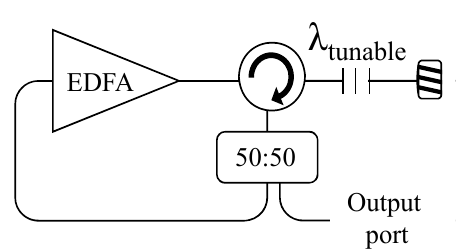
Figure 14. Basic design of the tunable laser.